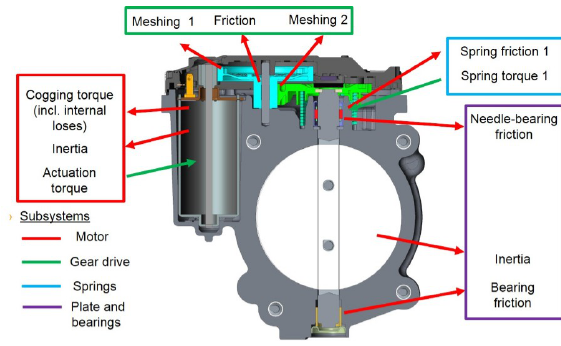
Figure 2. Section through the ACV